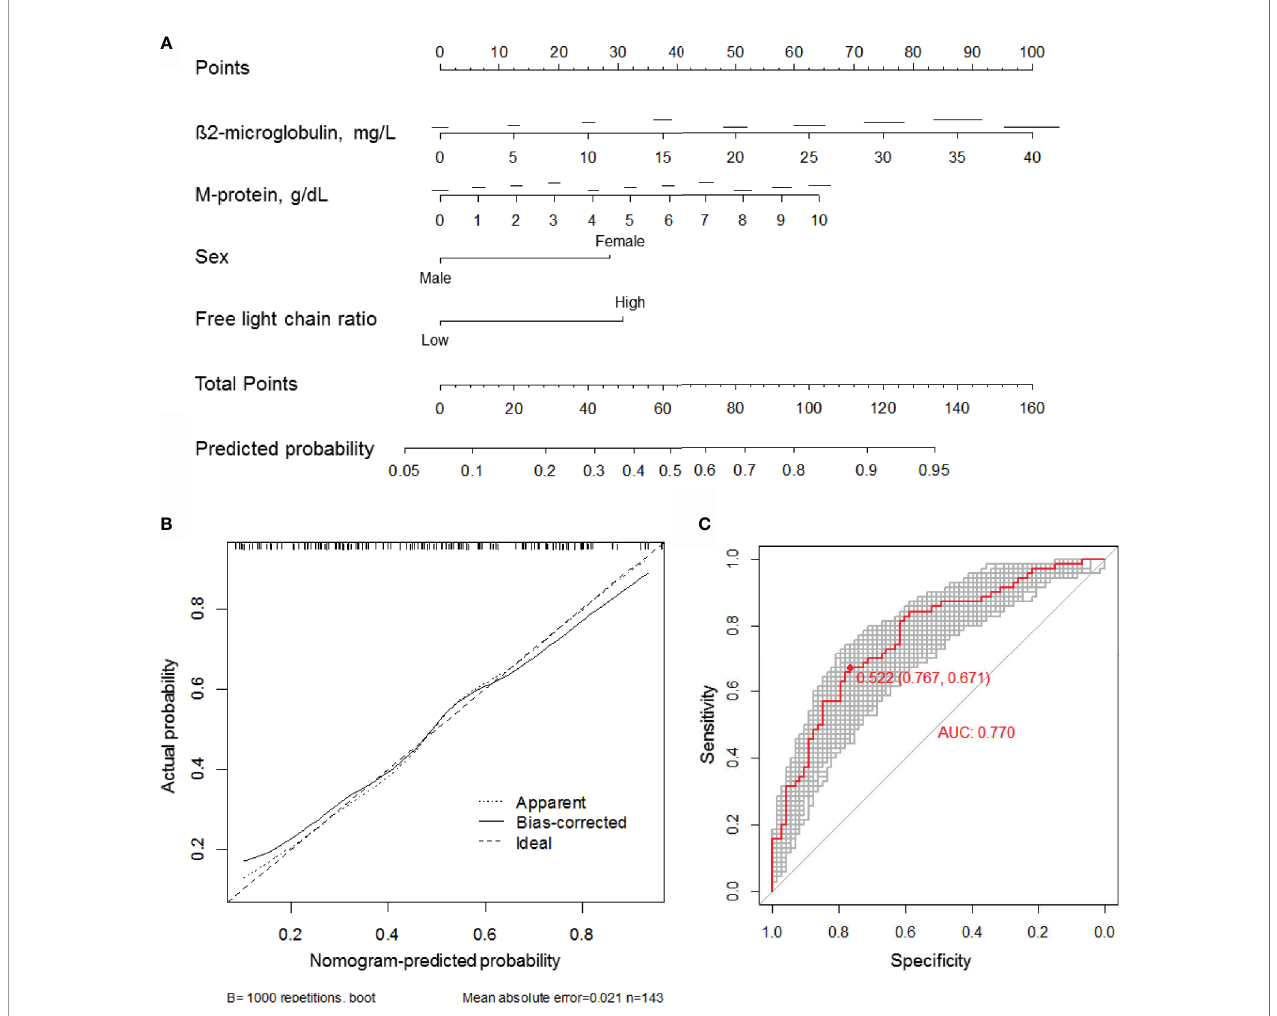
FIGURE 5 | Development of the CRBN prediction model. (A) A nomogram for estimating high (H-score ≥ 6) CRBN expression. (B) Calibration curves were created by plotting the actual probabilities (y-axis) against the nomogram-predicted probabilities (x-axis). Apparent model was constructed based on the original data. The bias-corrected model was obtained by subtracting the optimism estimate from the apparent performance. The optimism estimate was calculated as the difference between bootstrap performance with 1,000 repetitions and the test performance. Test performance was obtained by applying the model to the original data without any modi fi cation. The 45-degree line indicates an ideal model. (C) ROC curves and AUC analyses with 1,000 bootstrap replicates for evaluating the performance and prediction accuracy of the nomogram model. AUC, area under the curve; ROC, receiver operating